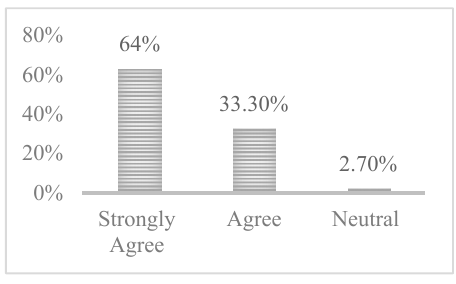
Figure 5. Coherence of FoMO-R.